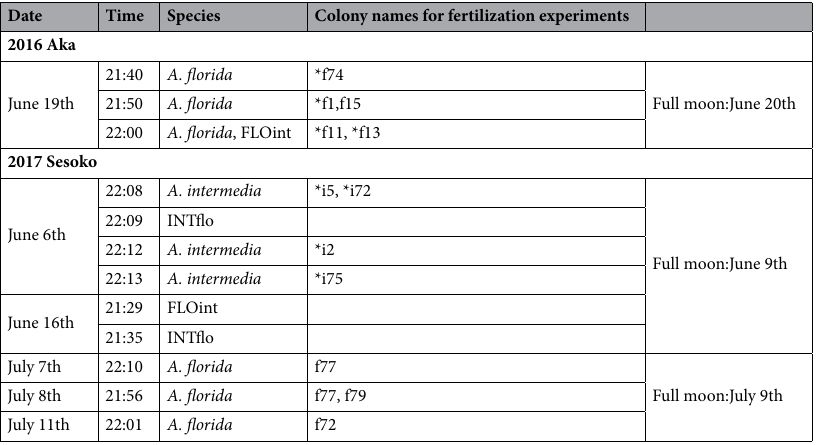
Table 1. Spawning time of the coral Acropora florida , A. intermedia , and hybrid (FLOint, INTflo) in 2016 at Aka Island and 2017 at Sesoko Island. *Indicate colonies used for crossing